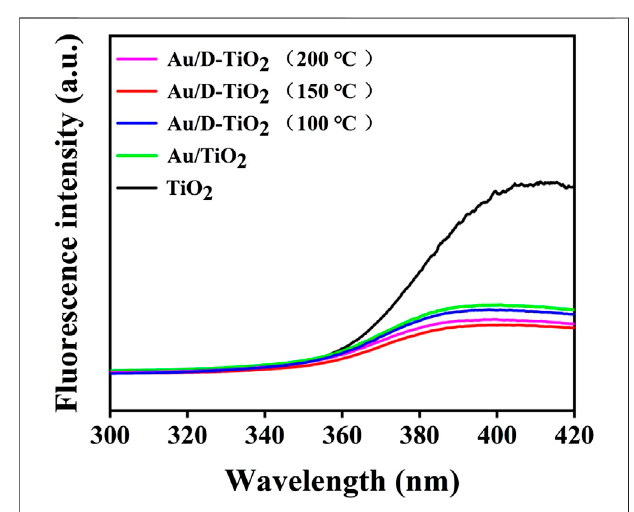
FIGURE 5 | PL spectra of TiO 2 , Au/TiO 2 and Au/D-TiO 2 (The D-TiO 2 were treated at 100 ° , 150 ° , and 200 ° C,